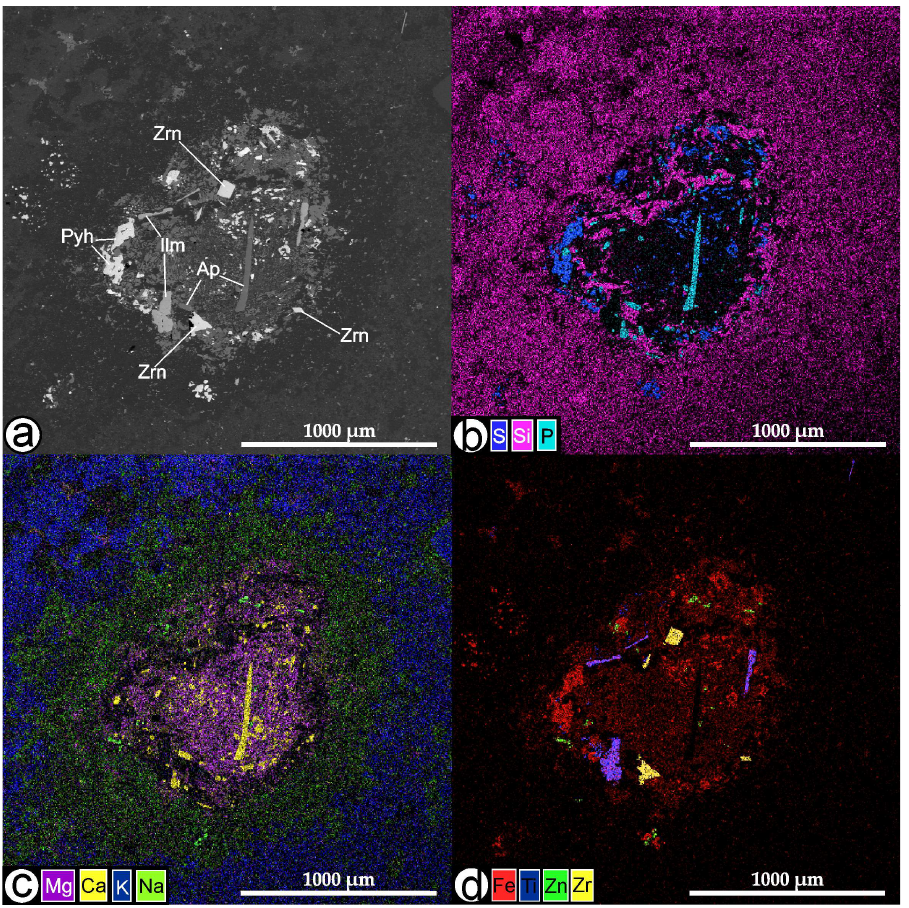
Figure 8. Element map of the “nodule”–mineral separation in the ground mass. ( a )—BSE. Characteristic X-ray map displaying the distribution: S, Si, P—( b ); Mg, Ca, K, Na—( c ); and Fe, Ti, Zn, Zr—( d ). Abbreviations: Ap, apatite; Ilm, ilmenite; Zrn, zircon; and Pyh, pyrhotite.